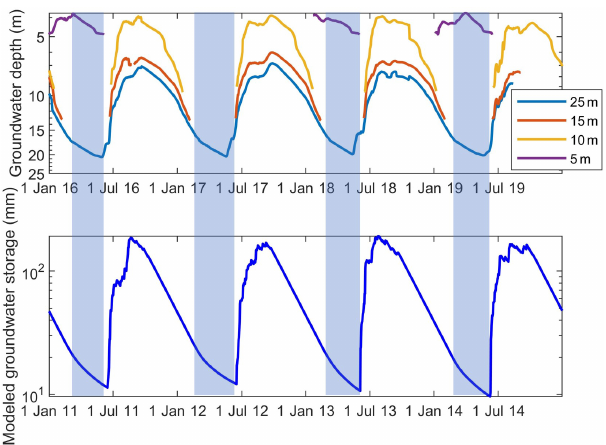
Figure 11. Observed groundwater depth from 2016 to 2019 at WW01 wells, at depths of 5, 10, 15, and 25m, and the simulated groundwater storage by the FLEX-Topo-FS model from 2011 to